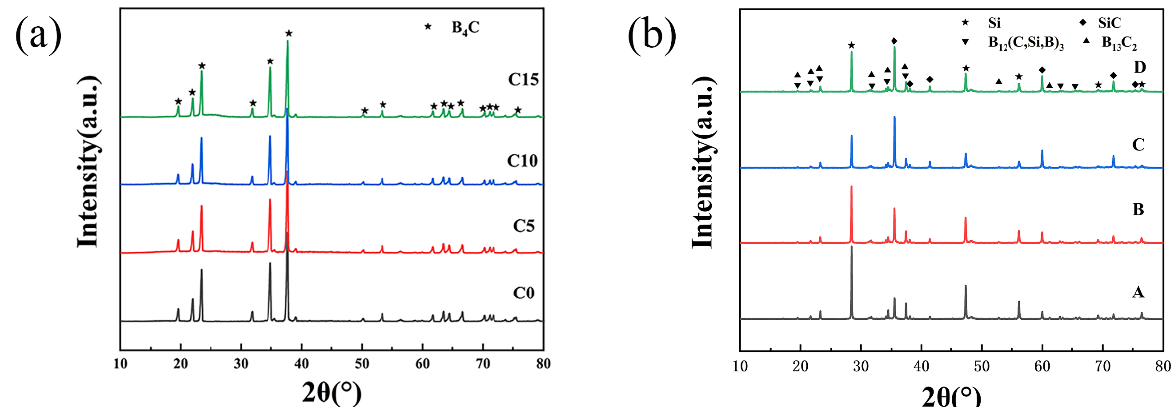
Figure 2. ( a ) XRD patterns of raw powder (mixture of B 4 C and C); ( b )XRD patterns of composites with different contents of carbon.